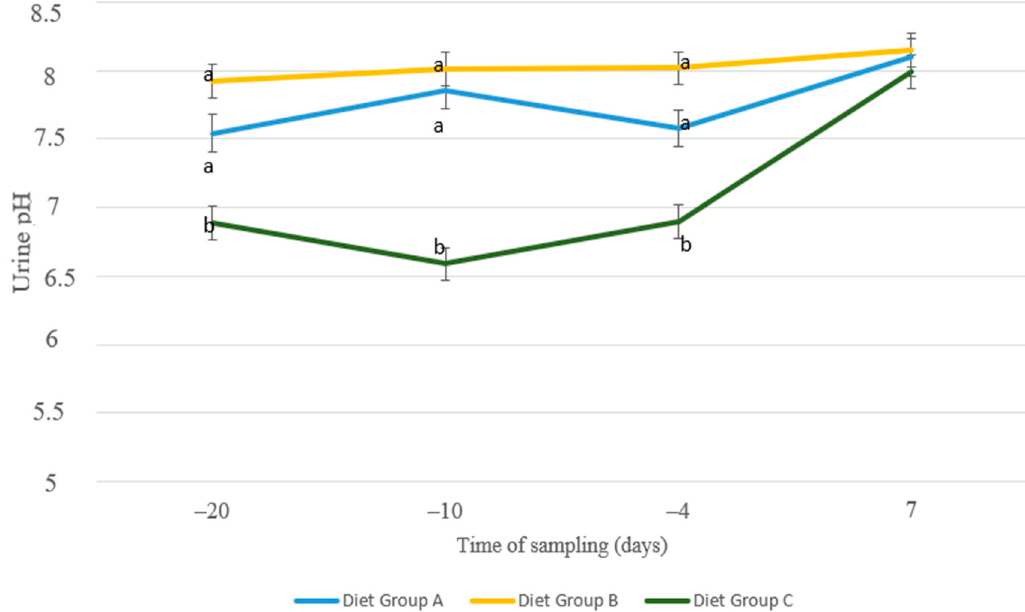
Figure 9. Urine pH of sheep in group A (control group, n = 27), group B (supplemented diet with beet pulp, n = 31), and group C (supplemented diet with beet pulp and ammonium chloride, n = 29) during the peri-parturient period. a,b Different letters denote significant differences between groups within evaluation time ( p < 0.05).